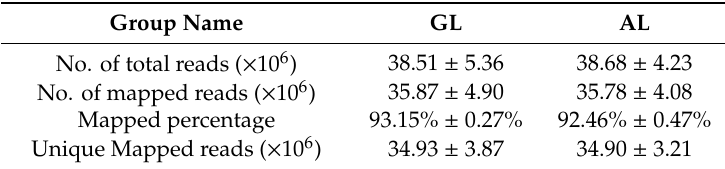
Figure 1. Chlorophyll content in leaves of pecan. ( A ): Photographs of green leaf (GL) seedling and albino leaf (AL) seedling. ( B ): Chlorophyll content in GL and AL. Mean values ( ± SD) of three biological replicates are shown. Di ff erent lowercase letters above the error bars indicate a significant di ff erence of correlation at 0.05 levels (one-way ANOVA, p -value < 0.05). Table 1. Sequencing and statistics for the two group’s transcriptome data with the reference genome (Cil.genome.fa).